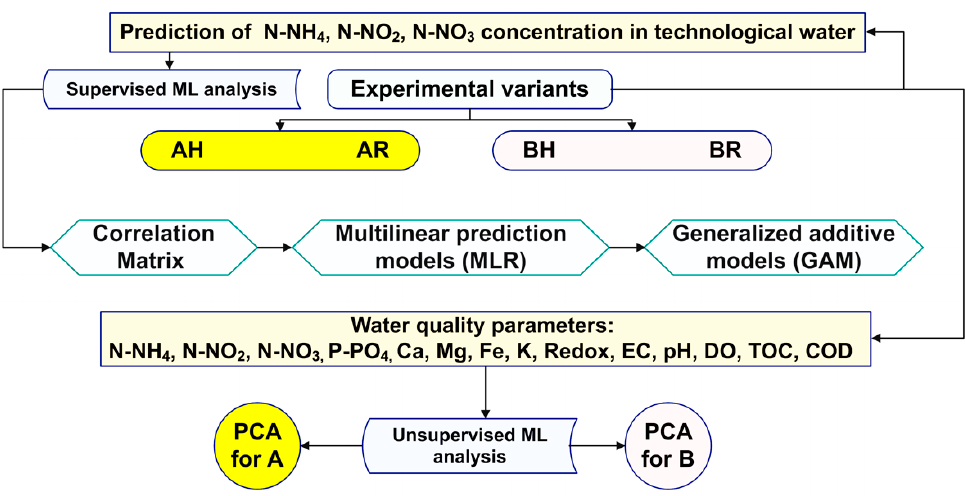
Figure 36. The analytical framework structure for developing water quality black-box sensors.